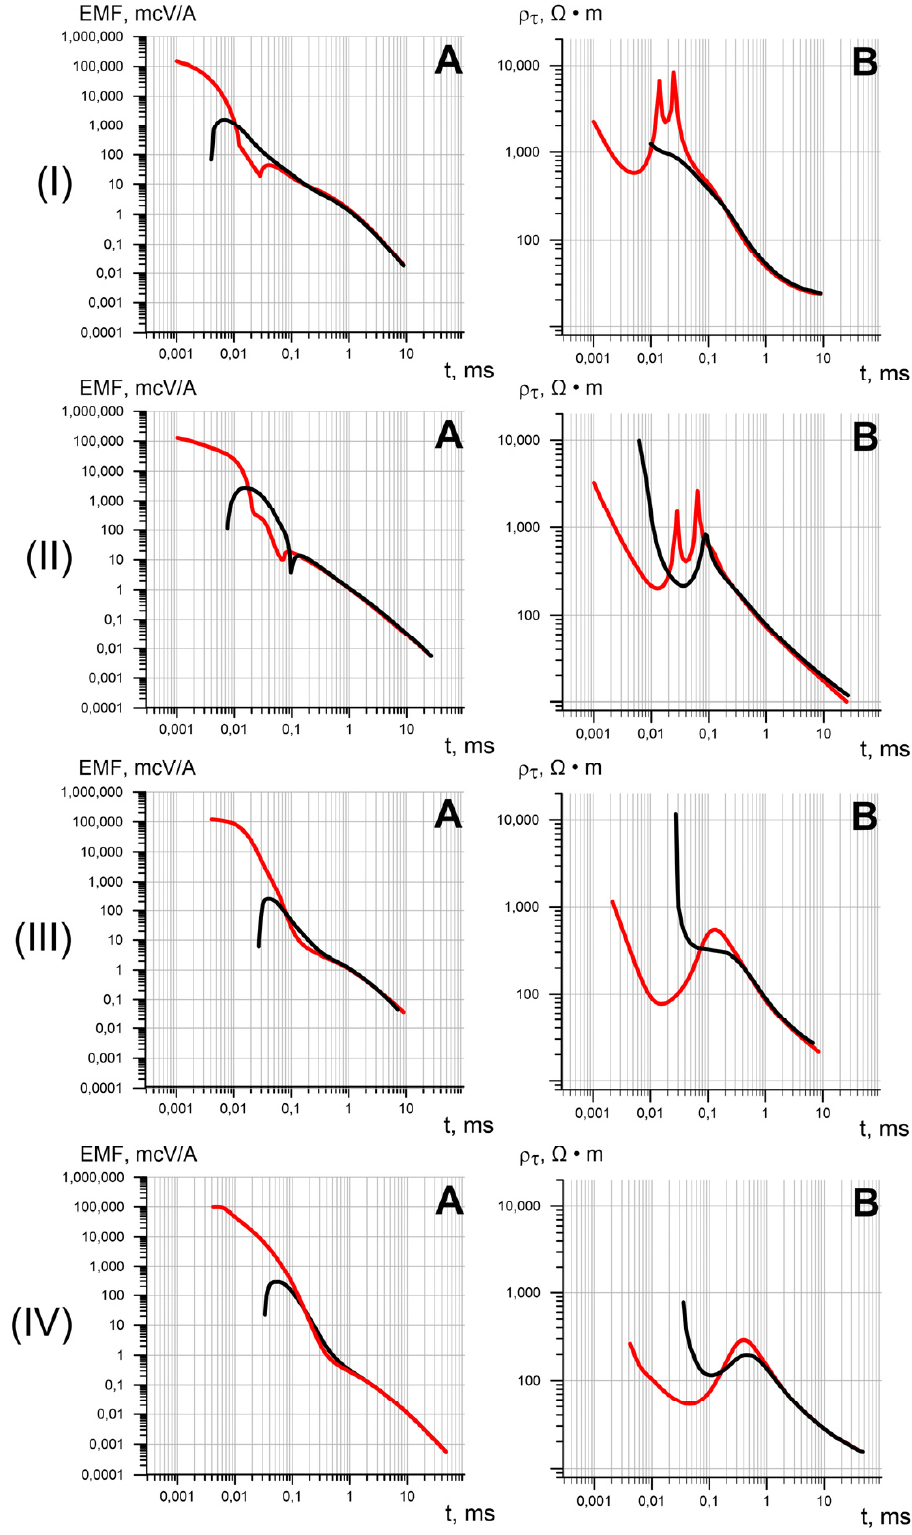
Figure 8. sTEM curves with IP effects collected in the Urengoi ( I ), northern Yamal ( II ), Nadym ( III ), and southern Ob Gulf ( IV ) areas, with central–loop (black) and loop–loop (red) arrays, at an offset of 100 m. Panels ( A , B ) show, respectively, time-dependent voltage decay and apparent resistivity.